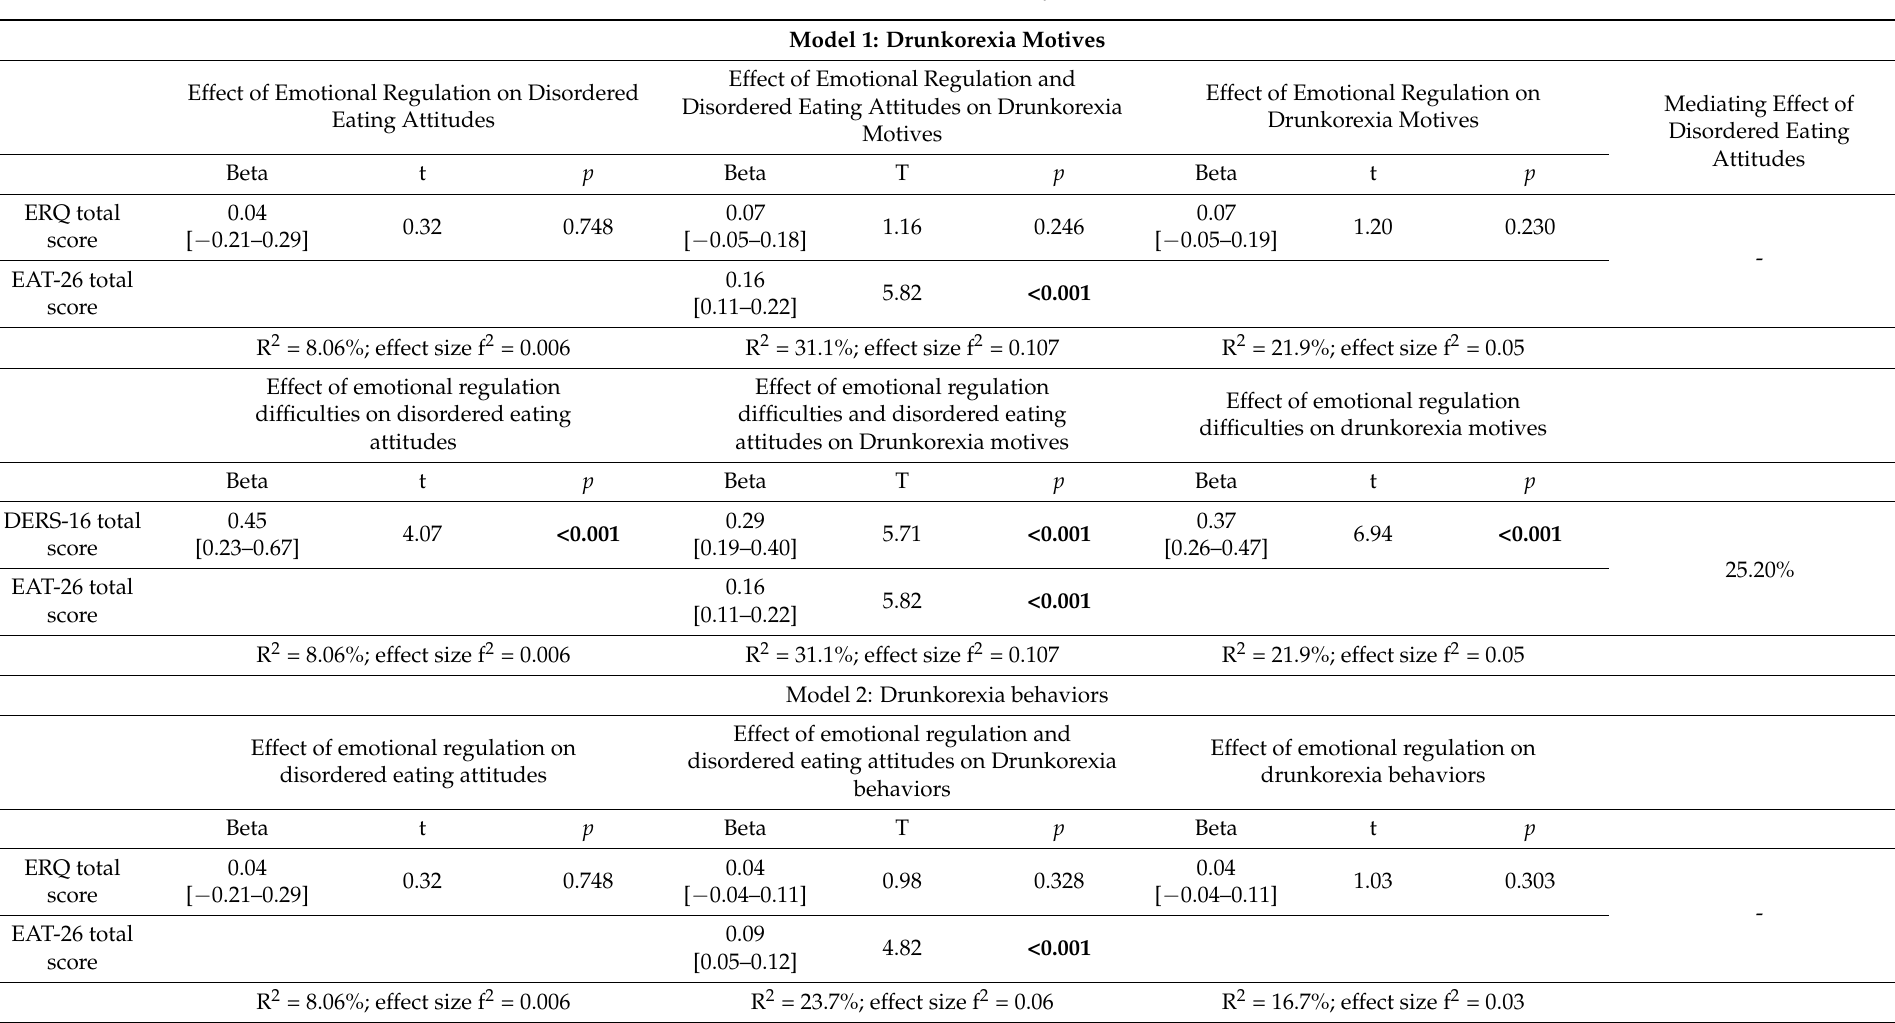
Table 5. Mediation